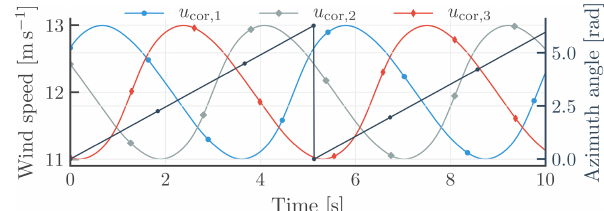
Figure 6. Time series of three generic wind speed measurements at the same amplitude, used for analysing the impact of the multiblade coordinate transformation. The first, second, and third signals have a phase shift of 30, 150, and 270 ◦ , respectively. The signals are constructed to include harmonics up to 6 P .